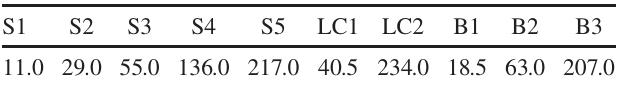
TABLE I. Distance in cm from the center of the solenoids, diagnostic chambers, and Bergoz current monitors to the down- stream edge of the gun